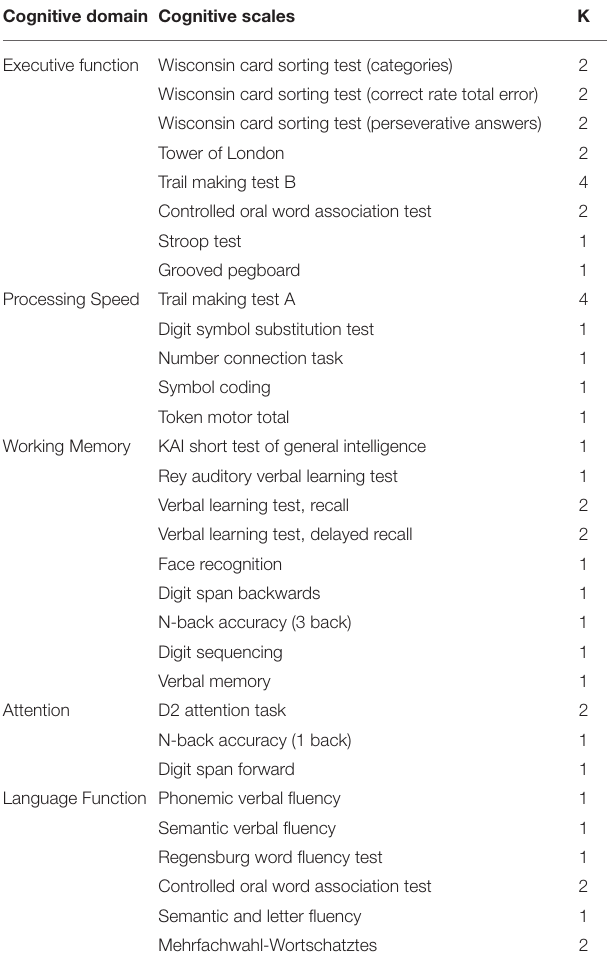
TABLE 1 | Cognitive scales included in the analyses. K, Number of